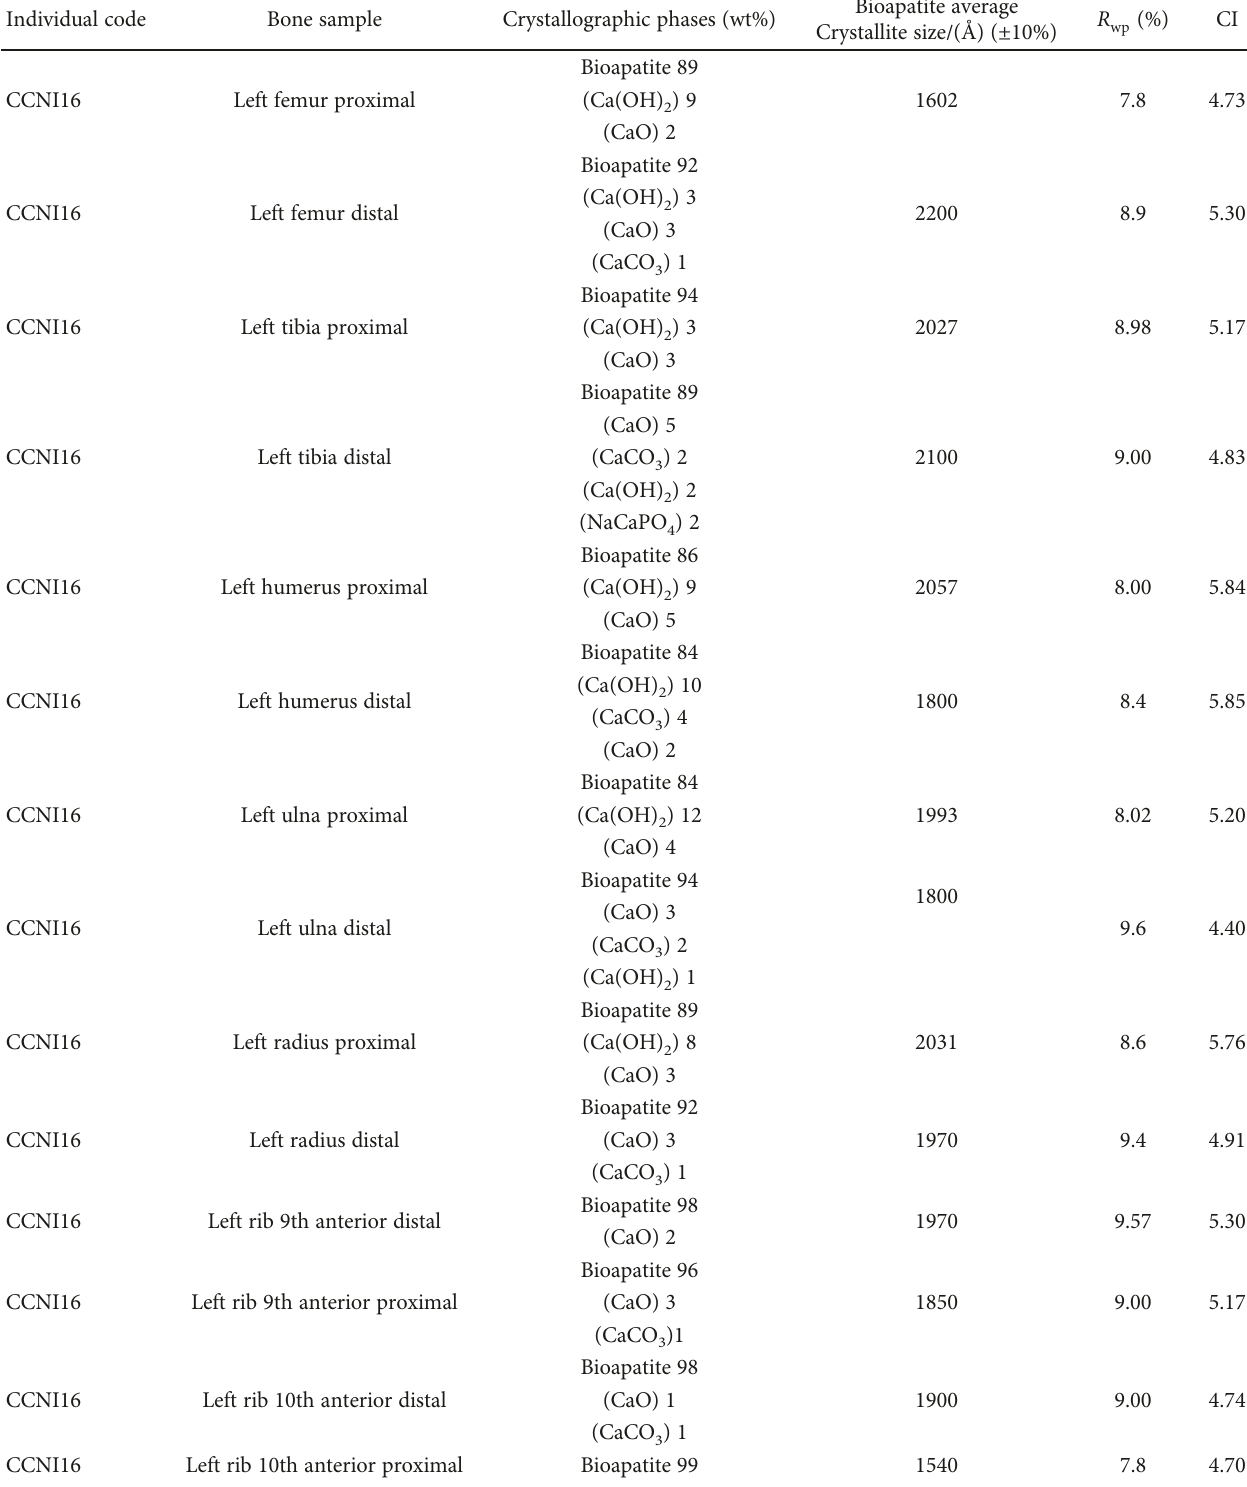
Table 1: List of the XRD phase investigation of the three modern human individuals, according to the Rietveld analysis. The uncertainty for the phase amount is calculated on the basis of statistical assumptions on the residual behaviour but generally holds about 10% of its value when the fi t is carried out correctly. The value for the mostly used agreement factor R wp (which is a test for the goodness of the fi t) in the re fi nement stage is also reported in the latter column. The average crystallite size of the hydroxyapatite mineral phase (1 Å =10 − 10 m) and CI from ATR-IR analysis have also been